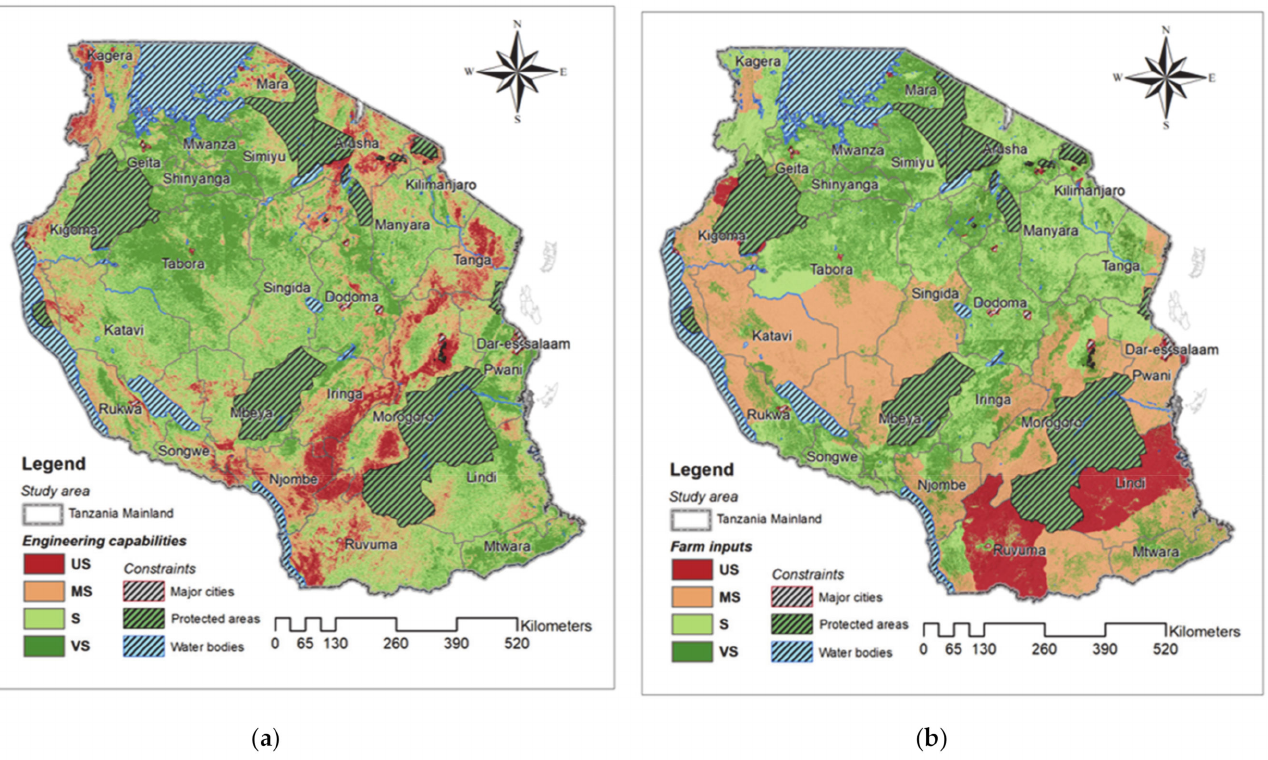
Figure 8. The distribution of suitability scores for; ( a ) engineering capabilities (soil texture and terrain) and; ( b ) availability of farm inputs (agriculture waste and